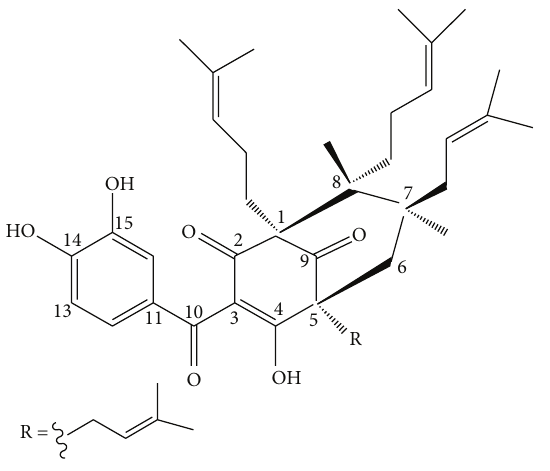
Figure 1: Molecular structure of Guttiferone A (BP).